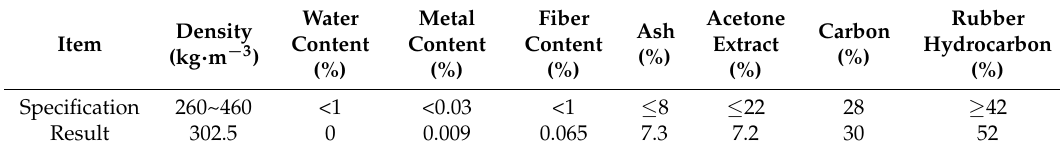
Table 2. Physical and chemical specifications of rubber